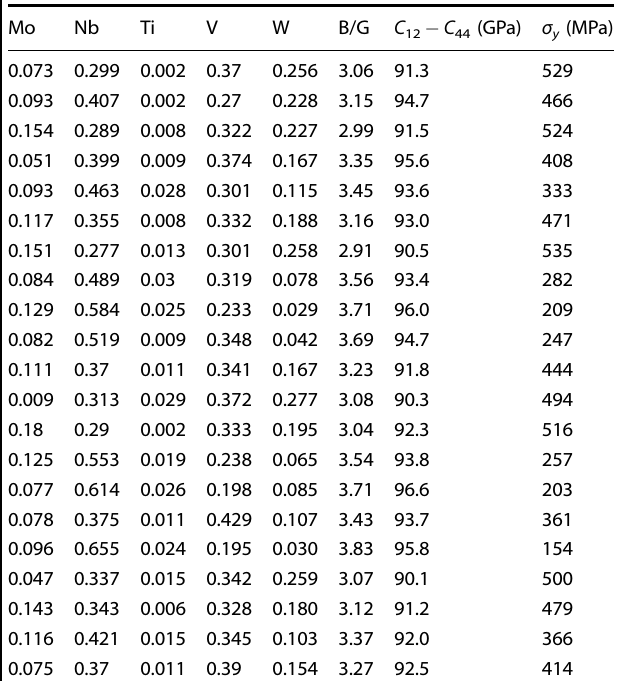
Table 2. The set of alloys that lie on the tri-objective strength-ductility Pareto-front identi fi ed by the proposed